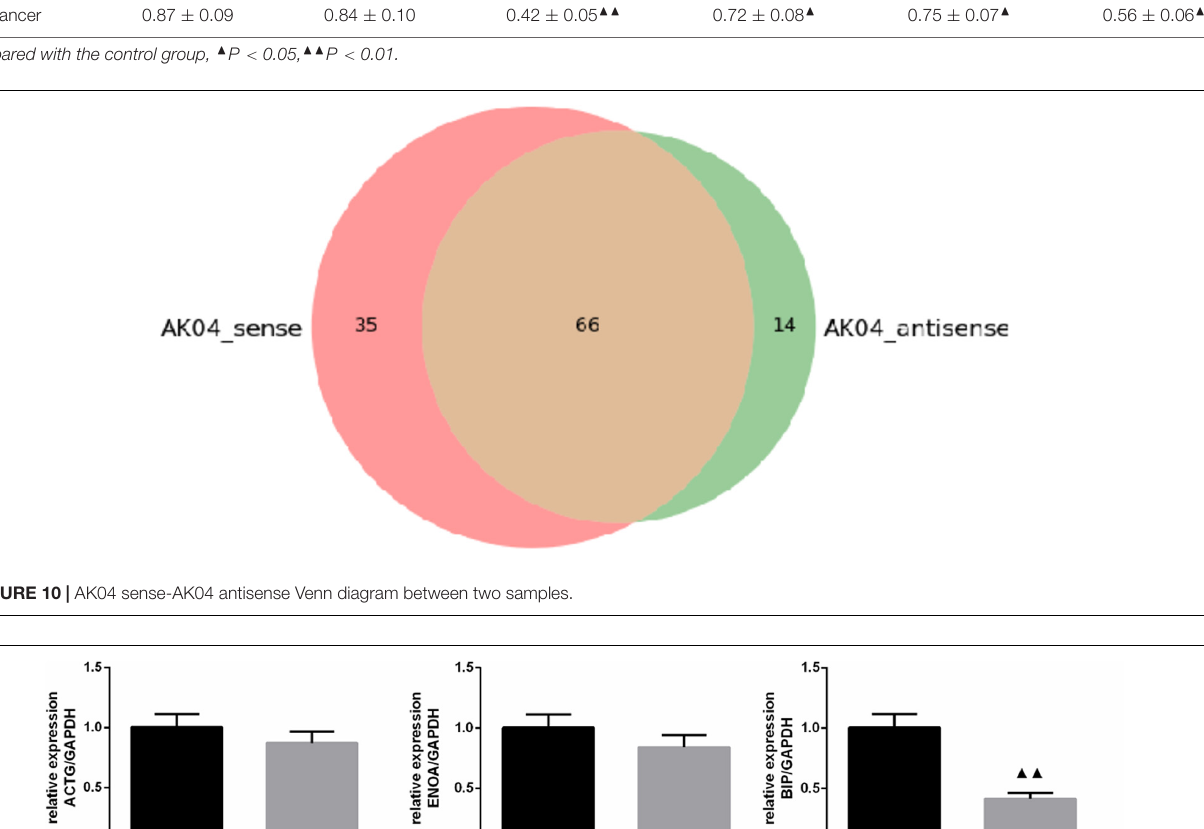
filtering out common contaminating proteins, the total number of proteins identified in the AK04_antisense and AK04_sense protein samples are 80 and 101, respectively. Some of the protein-related information with the top scores are shown in Table 8 . Among them, for the coverage of the target protein sequence information, in the sequence coverage pane of the Proteinpilot software,